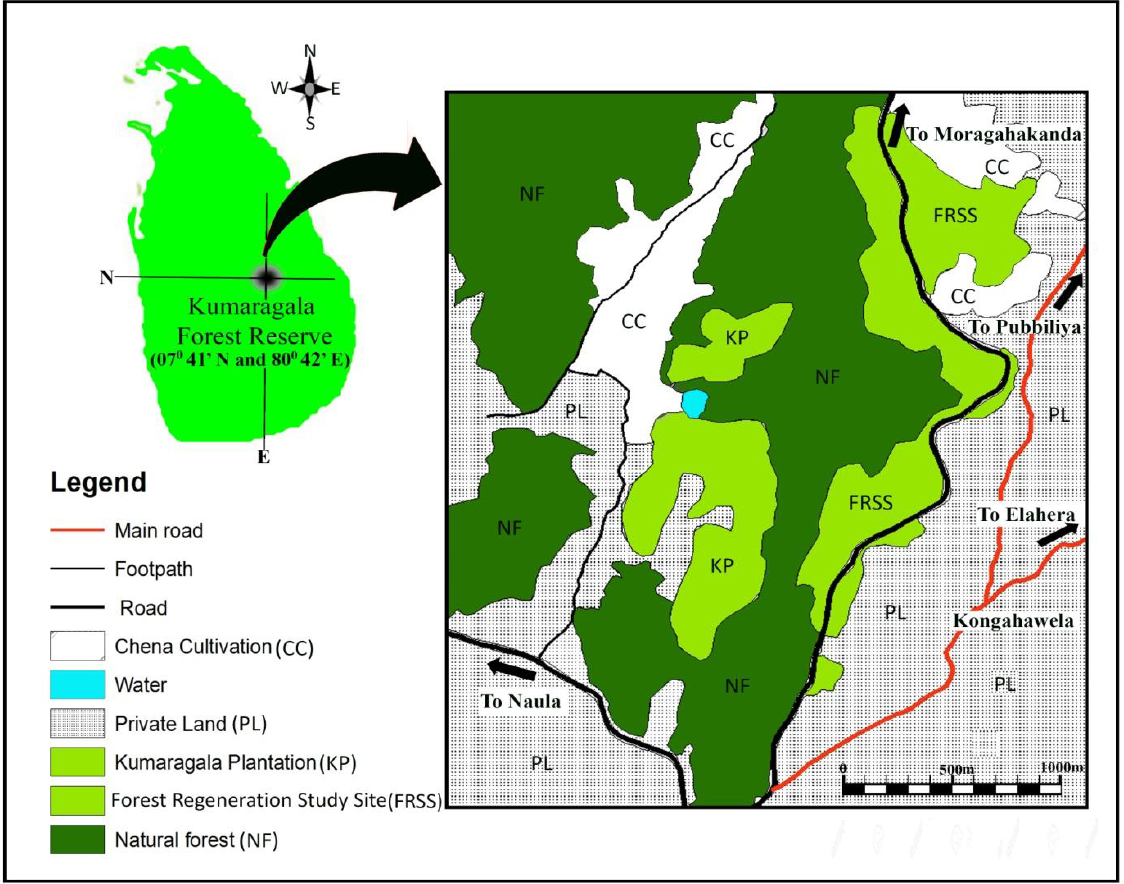
Figure 1: The Kumaragala forest reserve area showing major habitat